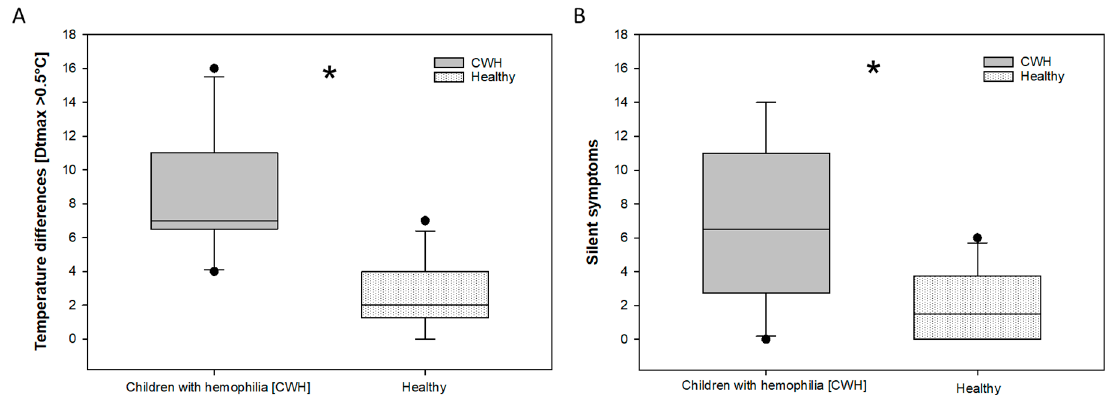
Figure 2. Thermographic side differences (>0.5 °C) ( A ) and corresponding silent symptoms/tender points ( B ) found in the groups of hemophilic and healthy children. Significant differences in temperature differences ( A ) were assessed by a student’s t -test. Significant differences in the amount of silent symptoms ( B ) were analyzed using the Mann-Whitney Rank Sum Test. Asterisks marks indicate significant differences with a p = <0.05.